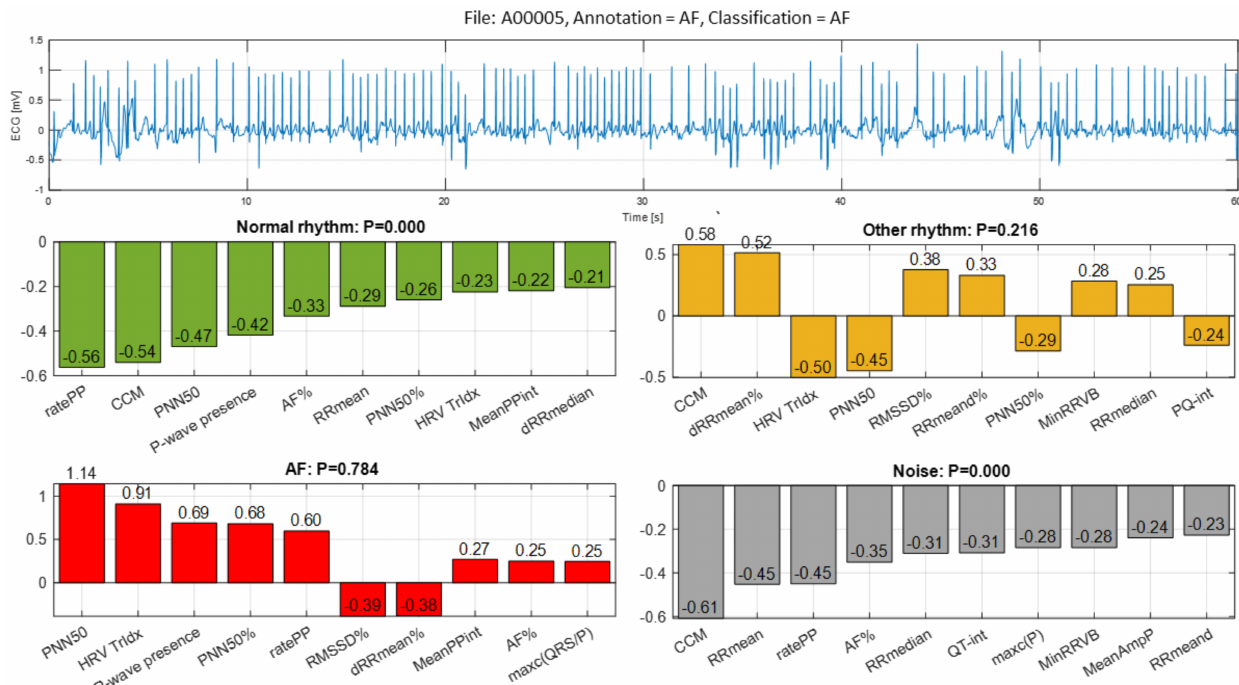
Figure 13. ECG example (file A00005) of correctly classified AF. The single-lead ECG strip is representative of non-sinus, narrow-complex rhythm with high-rate ventricular response and seemingly regular RR intervals in parts. This example presents a certain problem for visual differentiation between high-rate AF, atrial flutter (or alternation of AF and flutter) and AV-nodal re-entrant tachycardia. The barplots represent the Case Feature Importance of the top-10 ranked features, which maximally contribute to the output classification probability (P) of four rhythms. The ECG strip is detected as AF with very high probability (P = 0.784) based on HRV and atrial activity estimation, although Other rhythm (P = 0.216) based on six HRV features is also weakly indicated by DenseNet-3@128-32-4